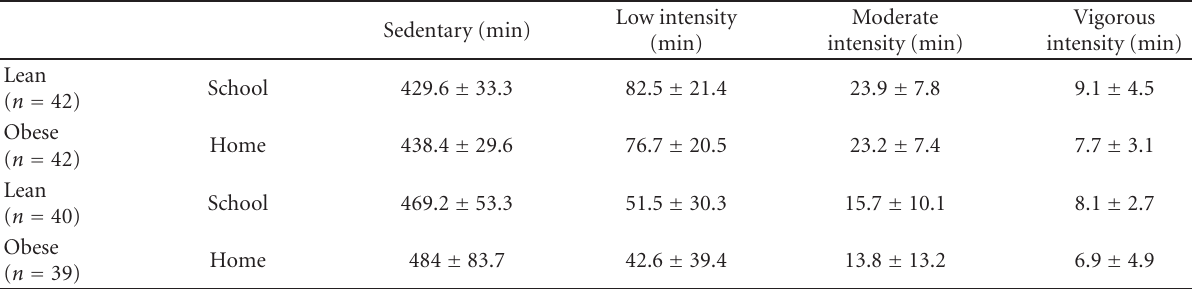
Table 3: Total minutes per day sedentary, in low, moderate, and vigorous activity in lean and obese children by location.